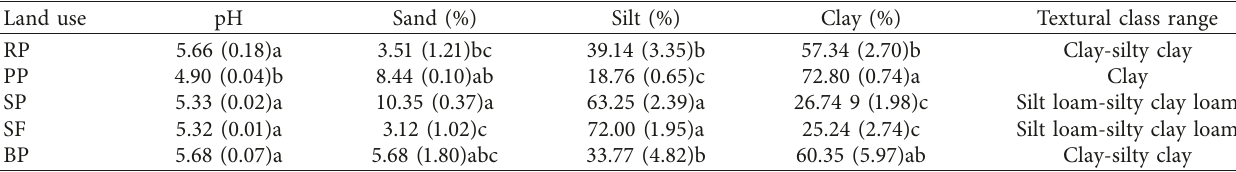
Table 2: pH, sand, silt, and clay properties in different land-use systems.